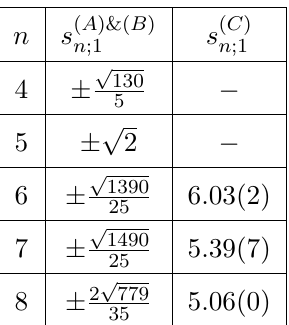
Table 3 . Leading corrections to the conformal spectra on branches ( A s ) , ( B s ) and ( C s )